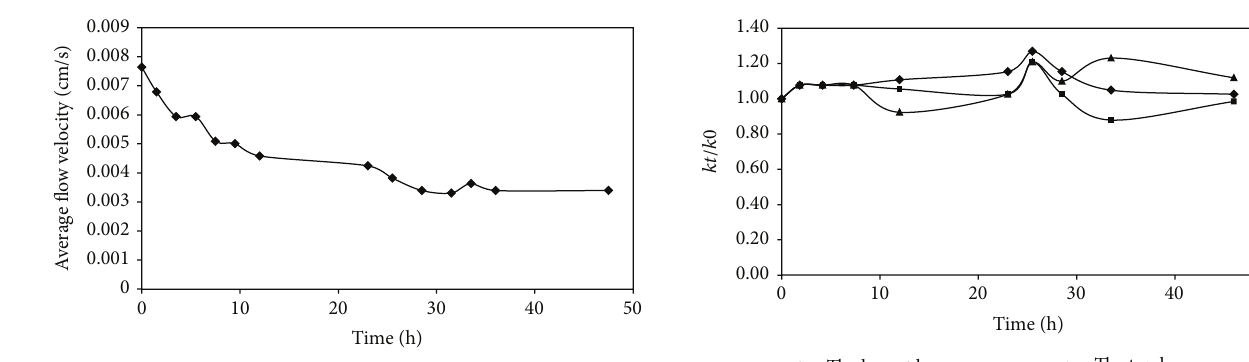
Figure 10: Relationship between the average flow velocity in the tailings column and time under the hydraulic gradient of 0.25 (experiment 3).